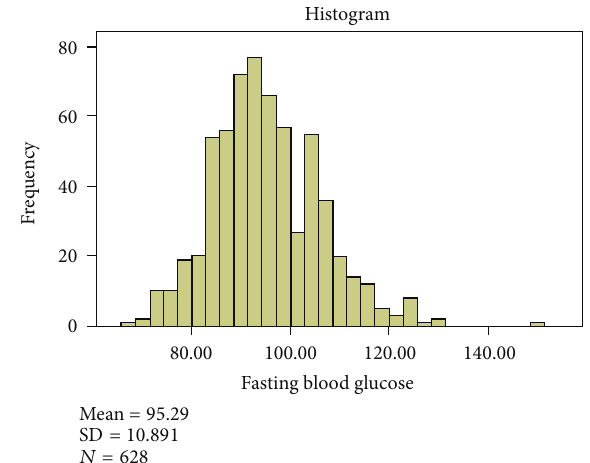
Figure 1: Fasting blood glucose (mg/dL) pattern in 628 secondary school